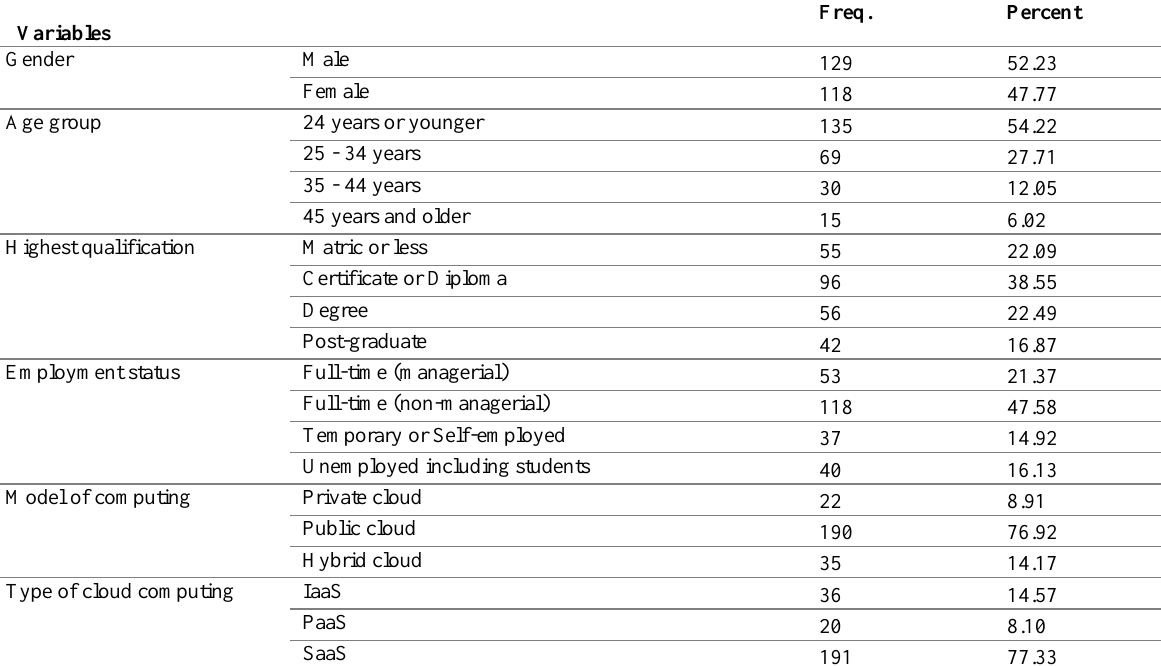
Table 1: Profile of the